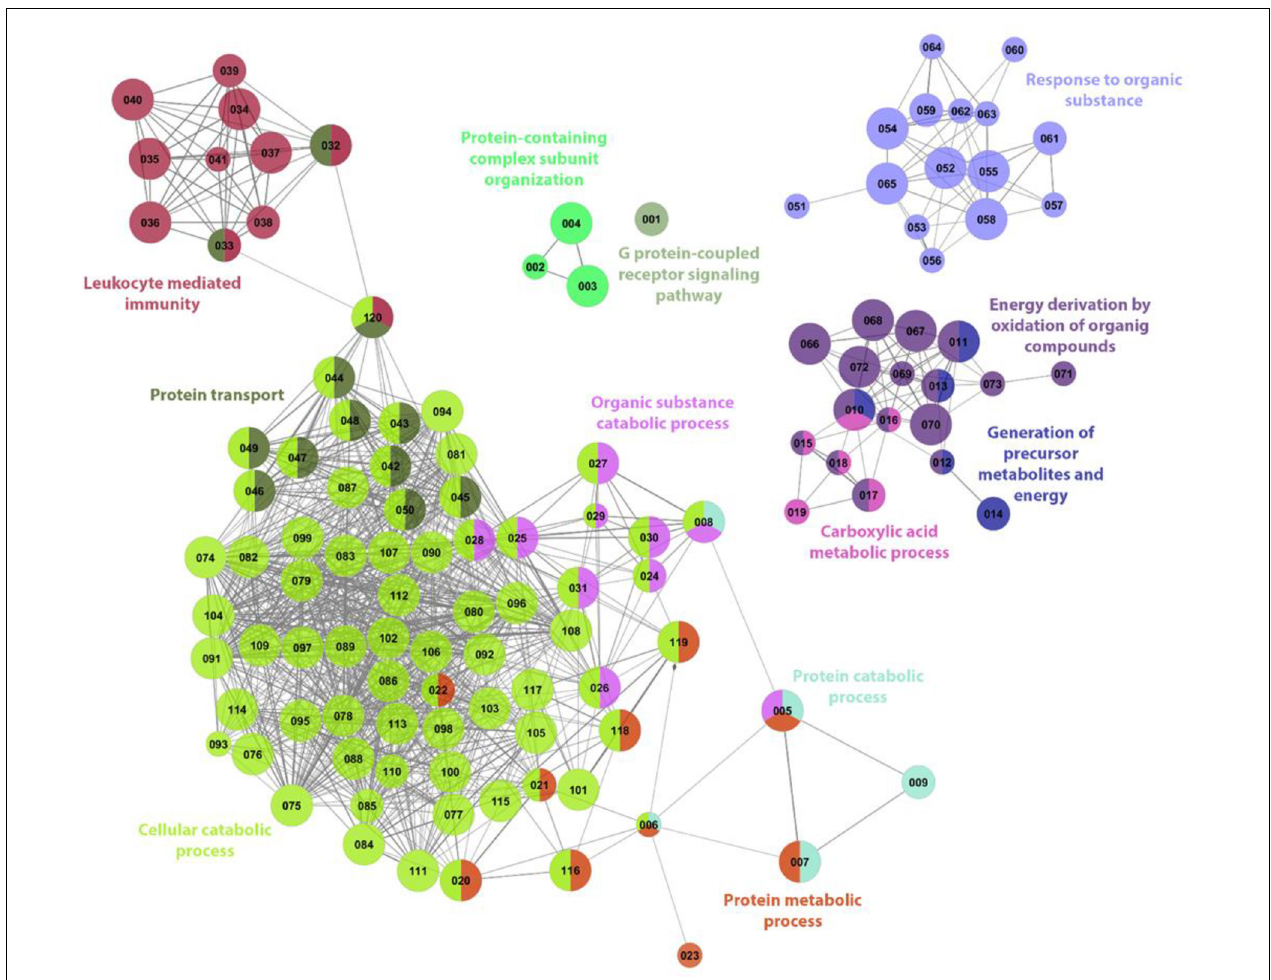
FIGURE 3 | ClueGo analysis of significantly enriched terms based on the biological functions in the anterior intestine of gilthead sea bream fed the SDPP diet. Each node represents one GO enrichment pathway (please refers to Supplementary Table 1 for details). The size of the node means its significance. Each color indicates a cluster of closely related biological processes. The colored biological term denominates the leading group term. The lines into the cluster showed a closed relationship between biological